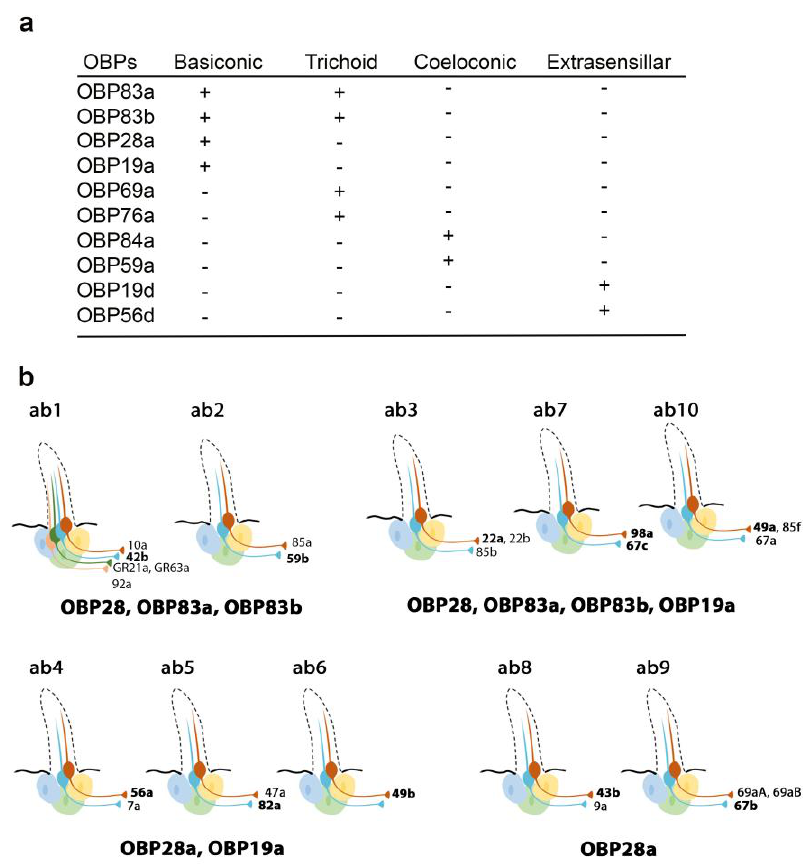
Figure 1. Expression patterns of the most abundant OBPs in Drosophila antennae. ( a ) Summary of the OBP expression patterns in the three types of antennal sensilla. OBP19d and OBP56g are expressed in epidermal cells. ( b ) Distribution of highly abundant OBPs expressed in Drosophila antennal basiconic sensilla. Olfactory receptor (OR) genes expressed in each olfactory receptor neuron class are indicated (all the OR genes except for GR21a and GR63a). The OR markers used for in situ hybridization for each sensilla are shown in bold [28,34].